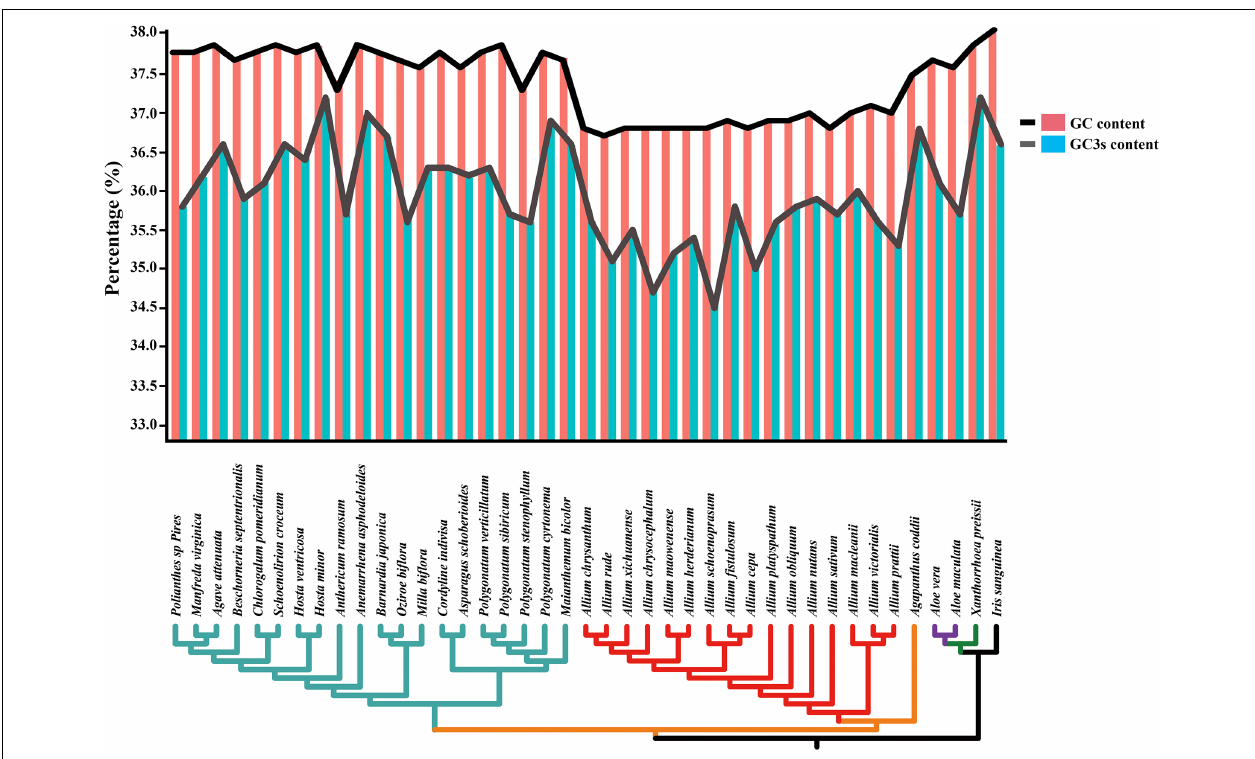
FIGURE 3 | Changes in plastid GC content of all 41 taxa. This graph shows the total GC content (red bar and black line) and the third codon position GC content (blue bar and gray line) of each